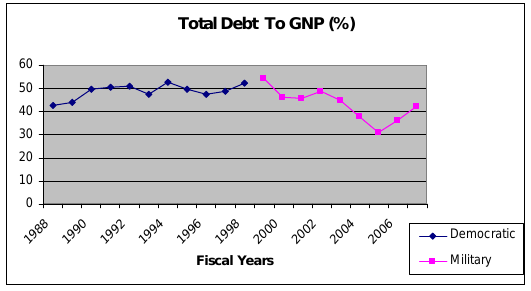
Graph 4 Source: Different economic surveys of